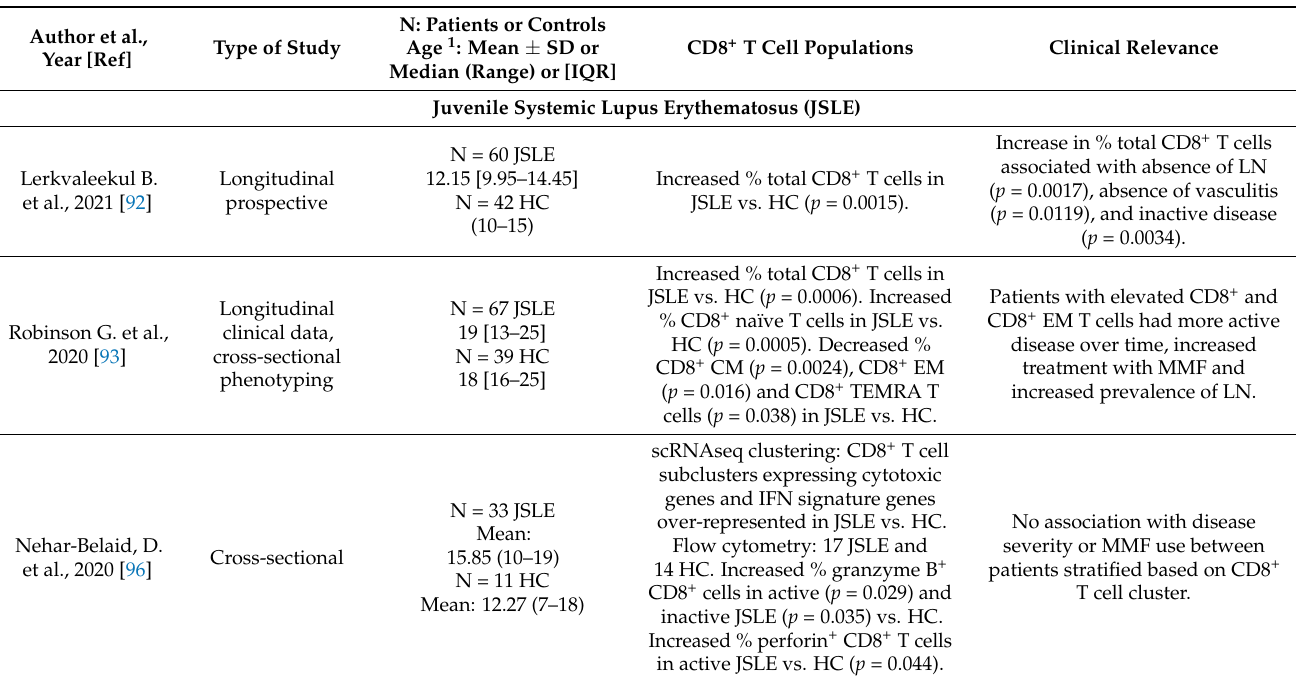
Table 4. Altered peripheral blood CD8 + T cell phenotype in children and adolescents with connective tissue